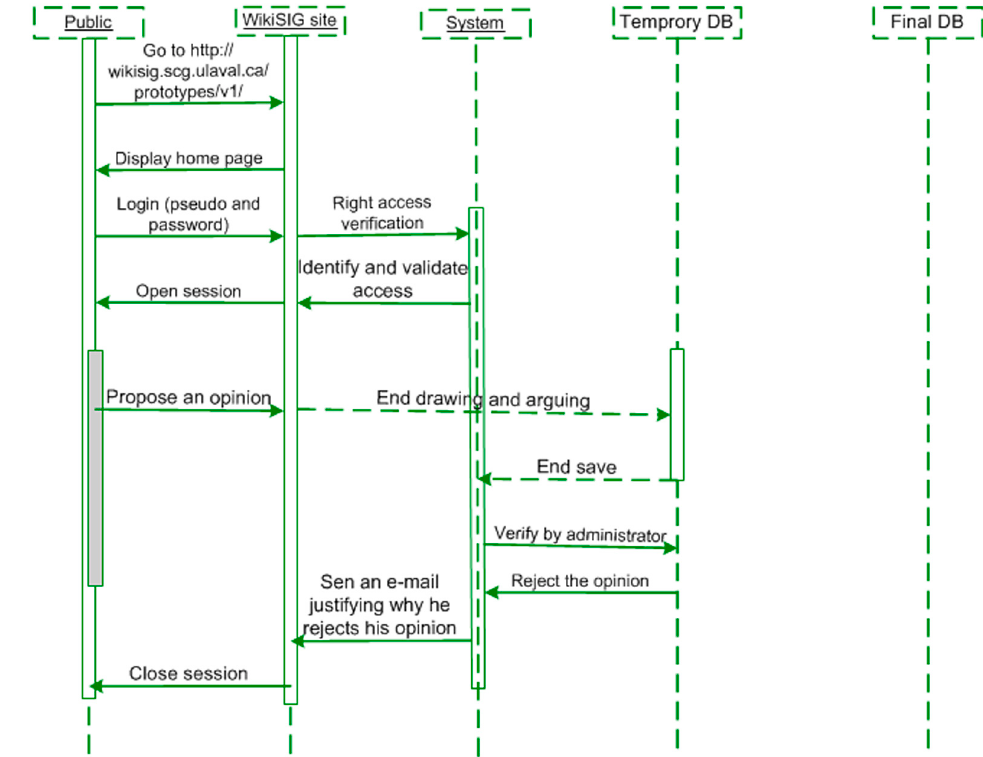
Figure 19. Sequence diagram of connected public where the opinion is rejected. Case 2: the proposed opinion is rejected by the